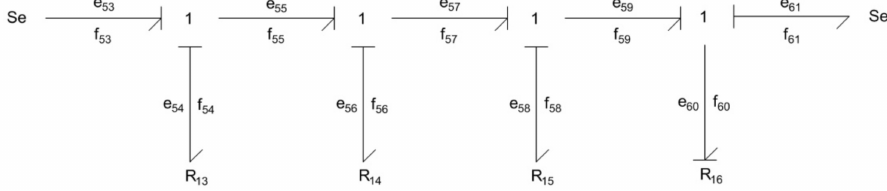
Figure 13. Bond graph model of the reactor heat transfer process.